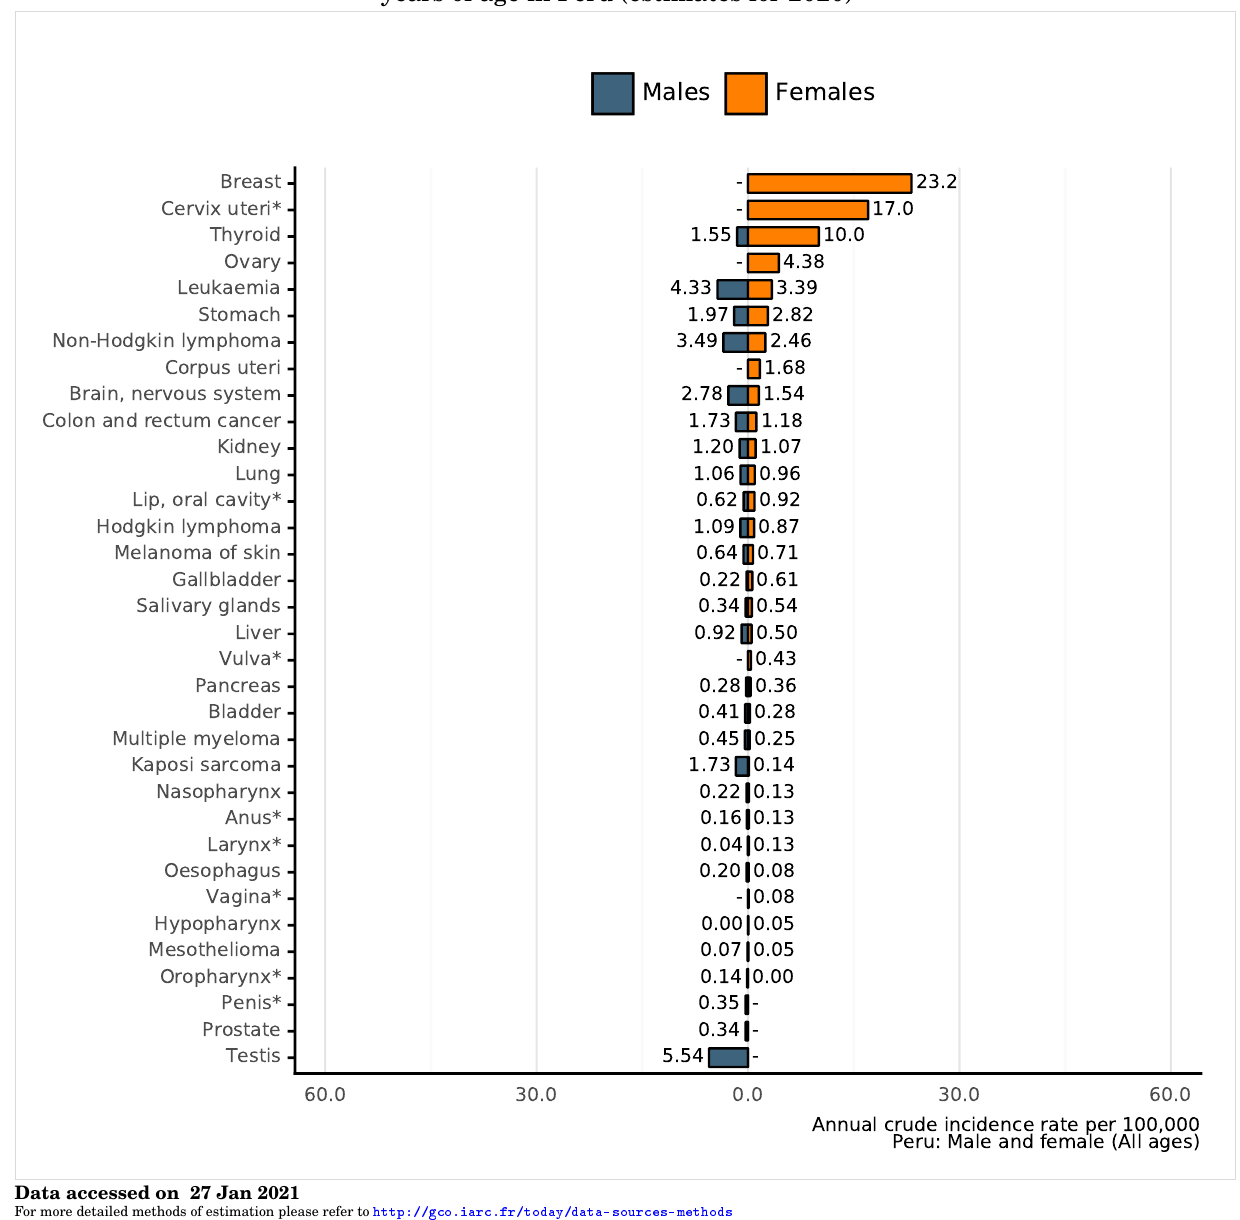
Figure 5: Comparison of HPV related cancers incidence to other cancers among men and women 15-44 years of age in Peru (estimates for